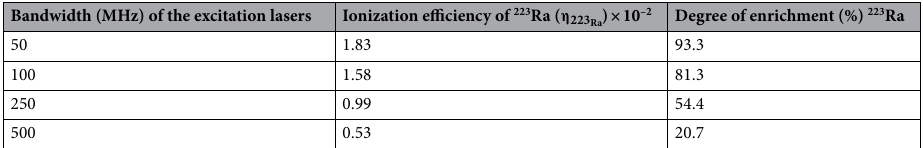
Table 3. A table of the degree of enrichment of 223 Ra for various bandwidths of the excitation lasers under Doppler free condition. Peak power density of the excitation and ionization lasers is 10, 10, 10,000 W/cm 2 .